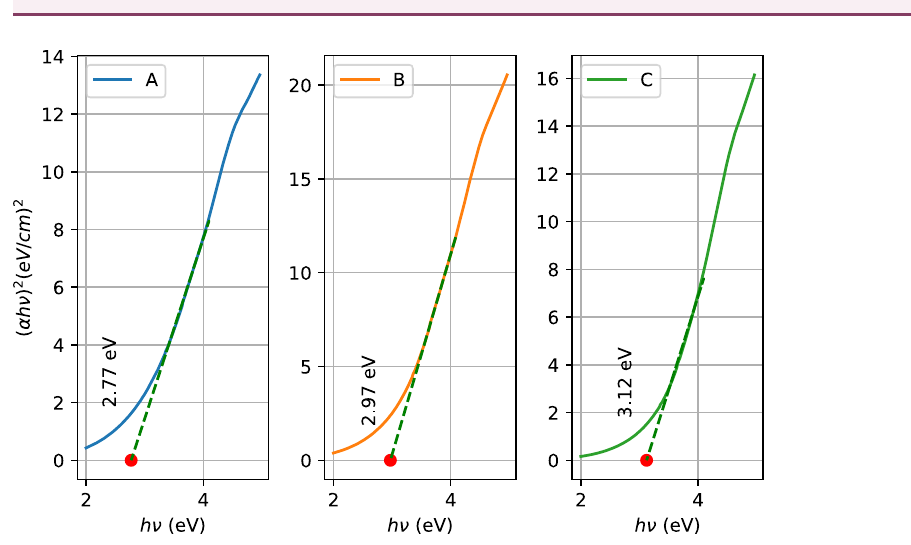
Figure 5 Tauc plots of BTO samples (A), (B) and (C) and the corresponding estimated band gap values, 2.77, 2.97 and 3.12 eV respectively. Given that the known band gap of bulk bismuth titanate in the perovskite form is around 3.1 eV, reduction of thickness of the nanosheets reduces the band gap of the